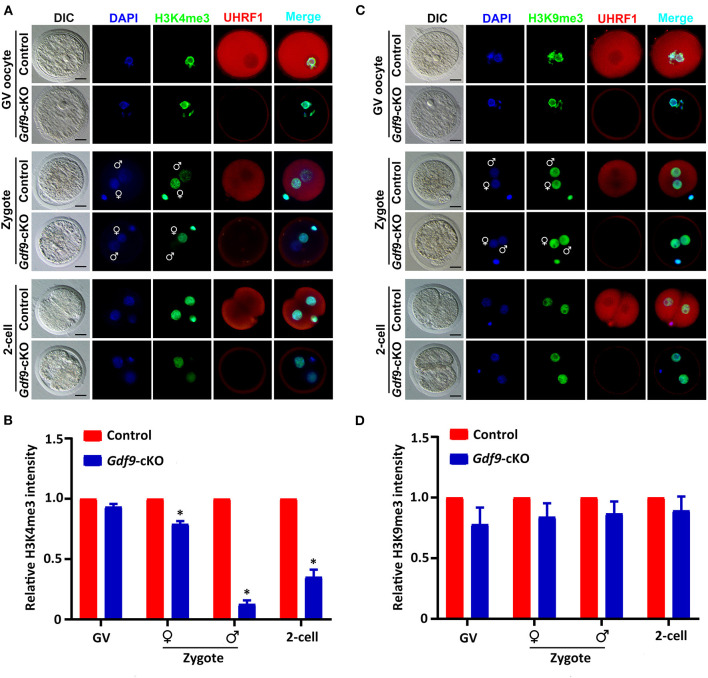
Maternal UHRF1 deficiency affects the H3K4me3 expression pattern but not H3K9me3 in zygote and two-cell embryos. (A) Immunofluorescent-staining using antibodies against H3K4me3 (in green) and UHRF1 (in red) at GV oocytes, zygotes, and two-cell embryos from control and Gdf9-cKO mice are shown. DNA was counterstained with DAPI (blue). Scale bar = 50 μm. (B) Quantification of the relative expression levels of H3K4me3 in control and Gdf9-cKO GV oocytes, zygotes, and two-cell embryos of (A). Data are presented as mean ± SEM. n = 3 independent experiments (total number of GV oocytes analyzed: n = 80 for control, n = 75 for Gdf9-cKO; total number of zygotes analyzed: n = 123 for control, n = 106 for Gdf9-cKO; total number of two-cell embryos analyzed: n = 96 for control, n = 83 for Gdf9-cKO), *p < 0.05. (C) Immunofluorescent-staining using antibodies against H3K9me3 (in green) and UHRF1 (in red) at GV oocytes, zygotes, and two-cell embryos from control and Gdf9-cKO mice are shown. DNA was counterstained with DAPI (blue). Scale bar = 50 μm. (D) Quantification of the relative expression levels of H3K9me3 in control and Gdf9-cKO GV oocytes (total number analyzed: n = 89 for control, n = 92 for Gdf9-cKO), zygotes (total number analyzed: n = 135 for control, n = 131 for Gdf9-cKO), and two-cell embryos (total number analyzed: n = 125 for control, n = 93 for Gdf9-cKO) of (C).